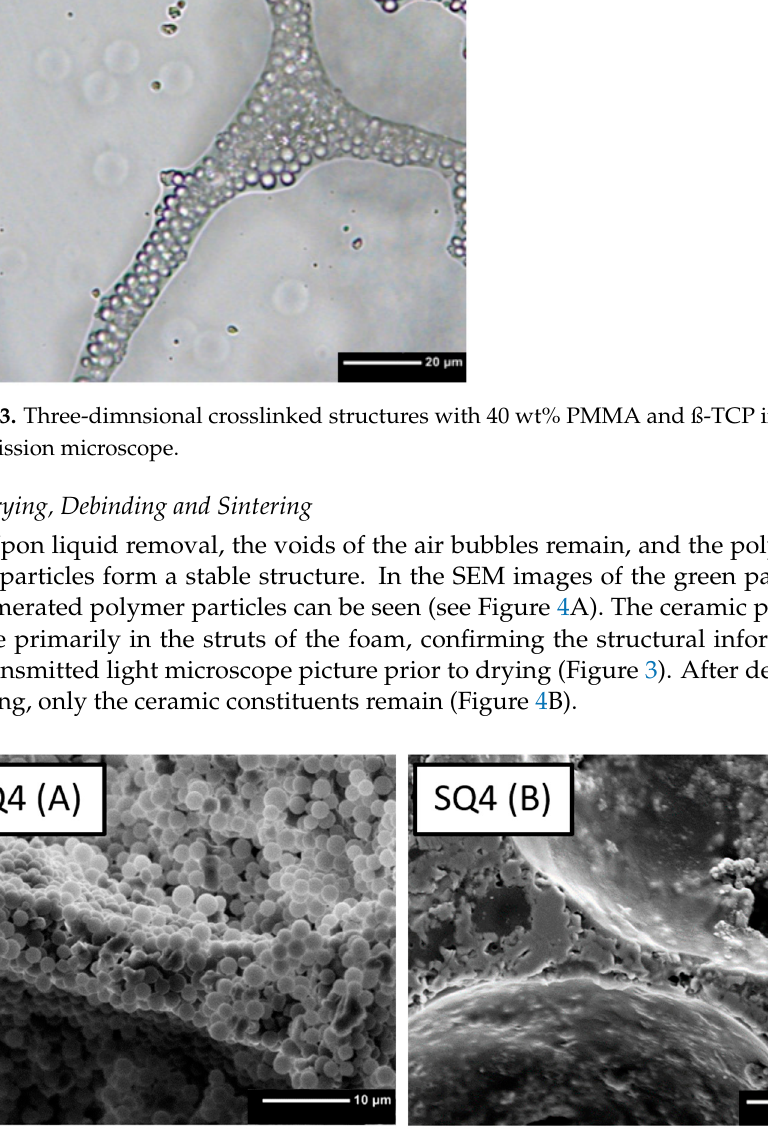
Figure 4. Comparison of non-sintered scaffold ( A ) containing 40 wt% PMSQ with the sintered scaffold ( B ).